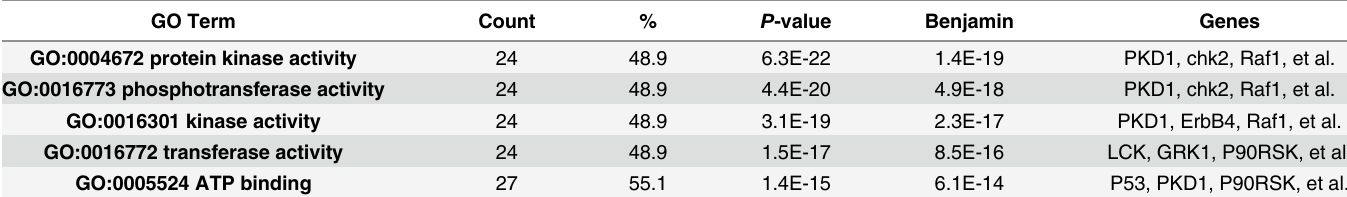
Table 5. Gene Ontology analysis (top five): molecular functions.